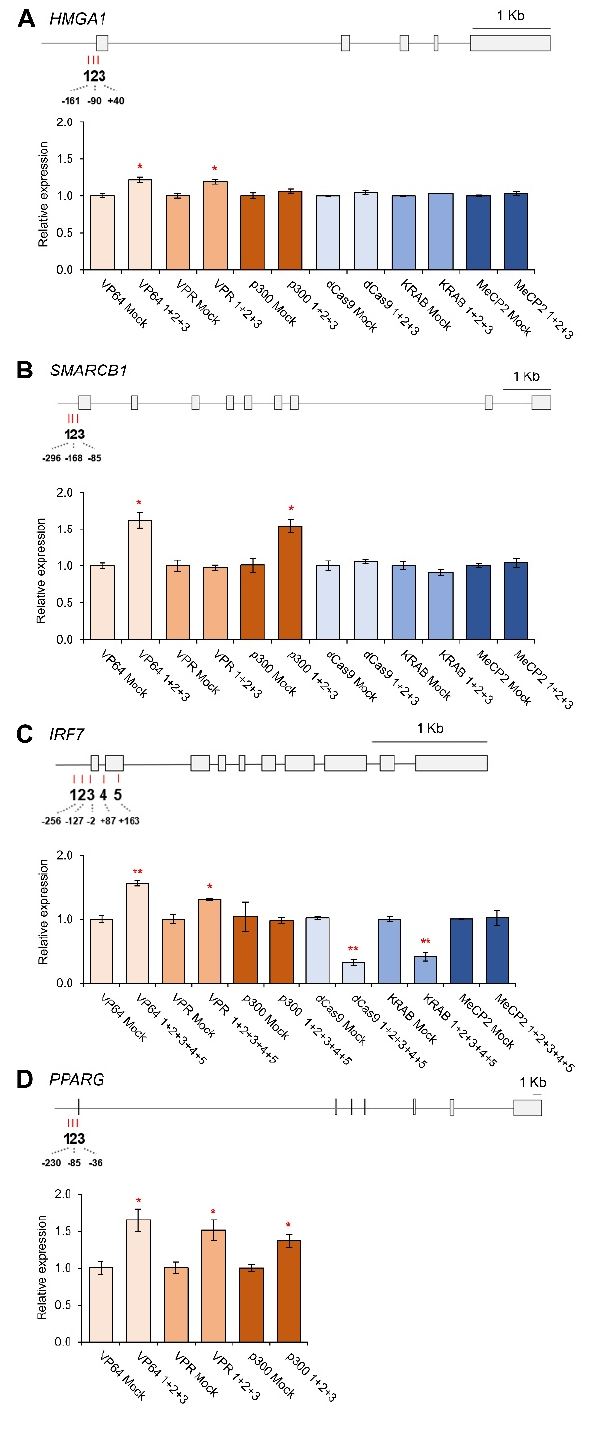
Figure 2. The regulation of the chicken HMGA1, SMARCB1, IRF7 and PPARG gene expression in CRISPRa and CRISPRi DF-1 cells. Gene structure and quantitative analysis of HMGA1 ( A ), SMARCB1 ( B ), IRF7 ( C ) and PPARG ( D ) in the gRNAs-treated CRISPRa and CRISPRi cell lines. The targeting positions of the gRNAs for each gene (1, 2 and 3 or 1, 2, 3, 4 and 5) were marked. Grey rectangles indicate exons. Scale bars, 1 Kb. Data are shown as the mean ± SEM. Significant differences between the mock controls and gRNAs-transfected samples were determined by Student’s t -test. Statistical significance was marked as * p < 0.05, ** p <